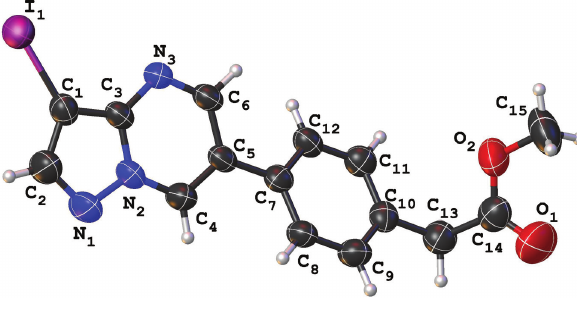
Table 1: Data collection and handling.